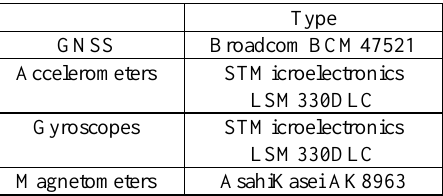
Table 1. GPS and motion sensors in Samsung Galaxy S4